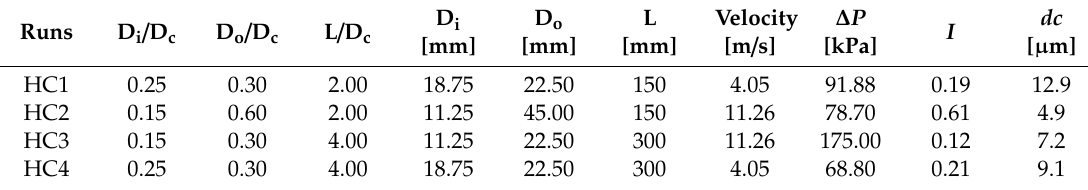
Table 6. Design matrix of experiments.